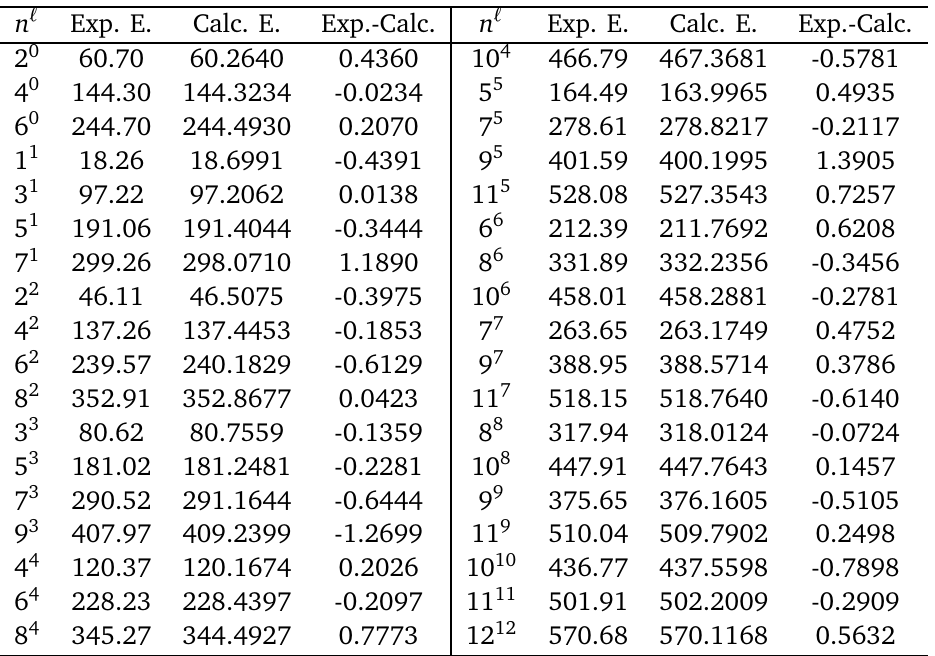
Table 4: Experimental [ 121 ] and calculated term values and residuals for the CCC bending mode of OCCCO. Units of cm − 1